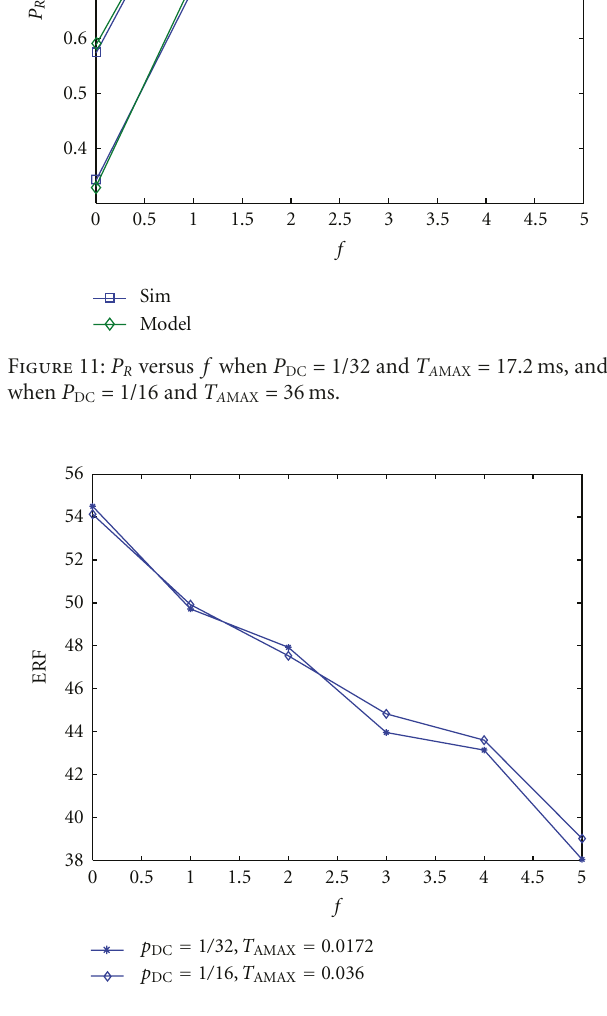
in both cases. In particular, f = 2 (resp. f = 3) is su ffi cient to achieve P R = 0 . 98 when the perturbation is 10% (resp. 15%).